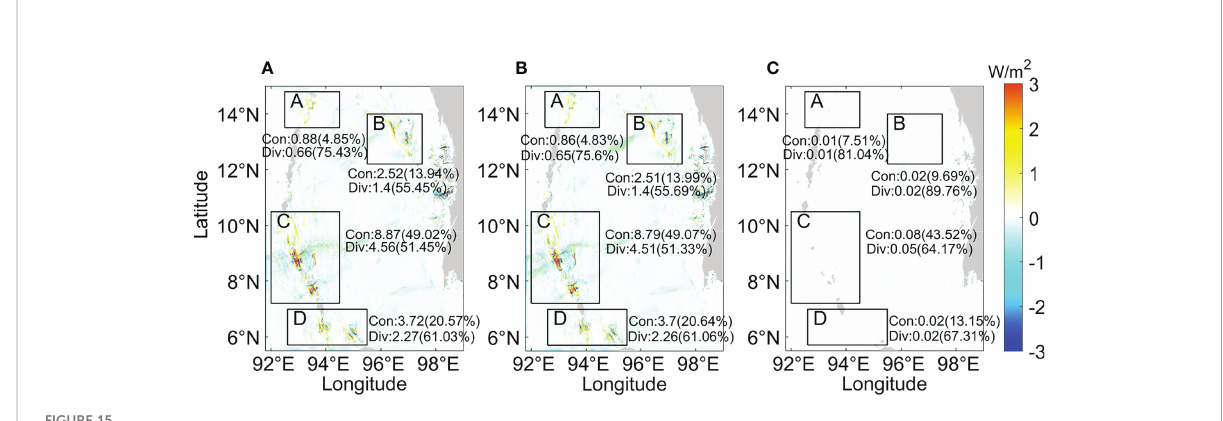
FIGURE 15 Same as Figures 14A – C, but during the entire tidal period (14